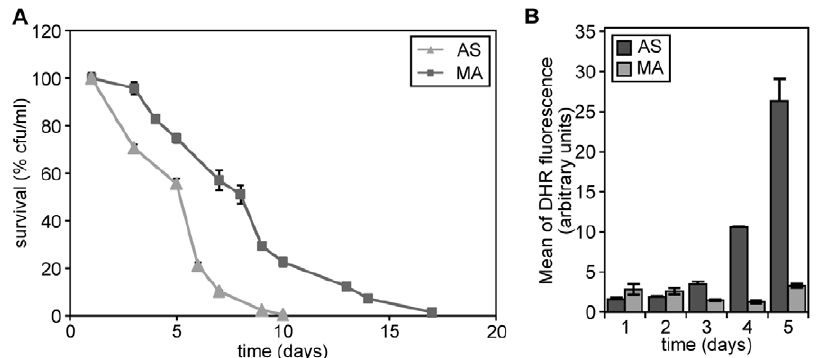
Figure 2. Chronological aging of H.polymorpha cells grown on different nitrogen sources. (A) CLS of wild-type cells following cultivation on 0.5% methanol in the presence of 0.25% AS or 0.25% MA s sole nitrogen sources. The lifespan curves shown represent the average of 4–6 experiments. (B) DHR fluorescence in cells grown on methanol in the presence of AS or MA at different time points during chronological aging. The bars indicate the standard error of mean of two independent experiments.